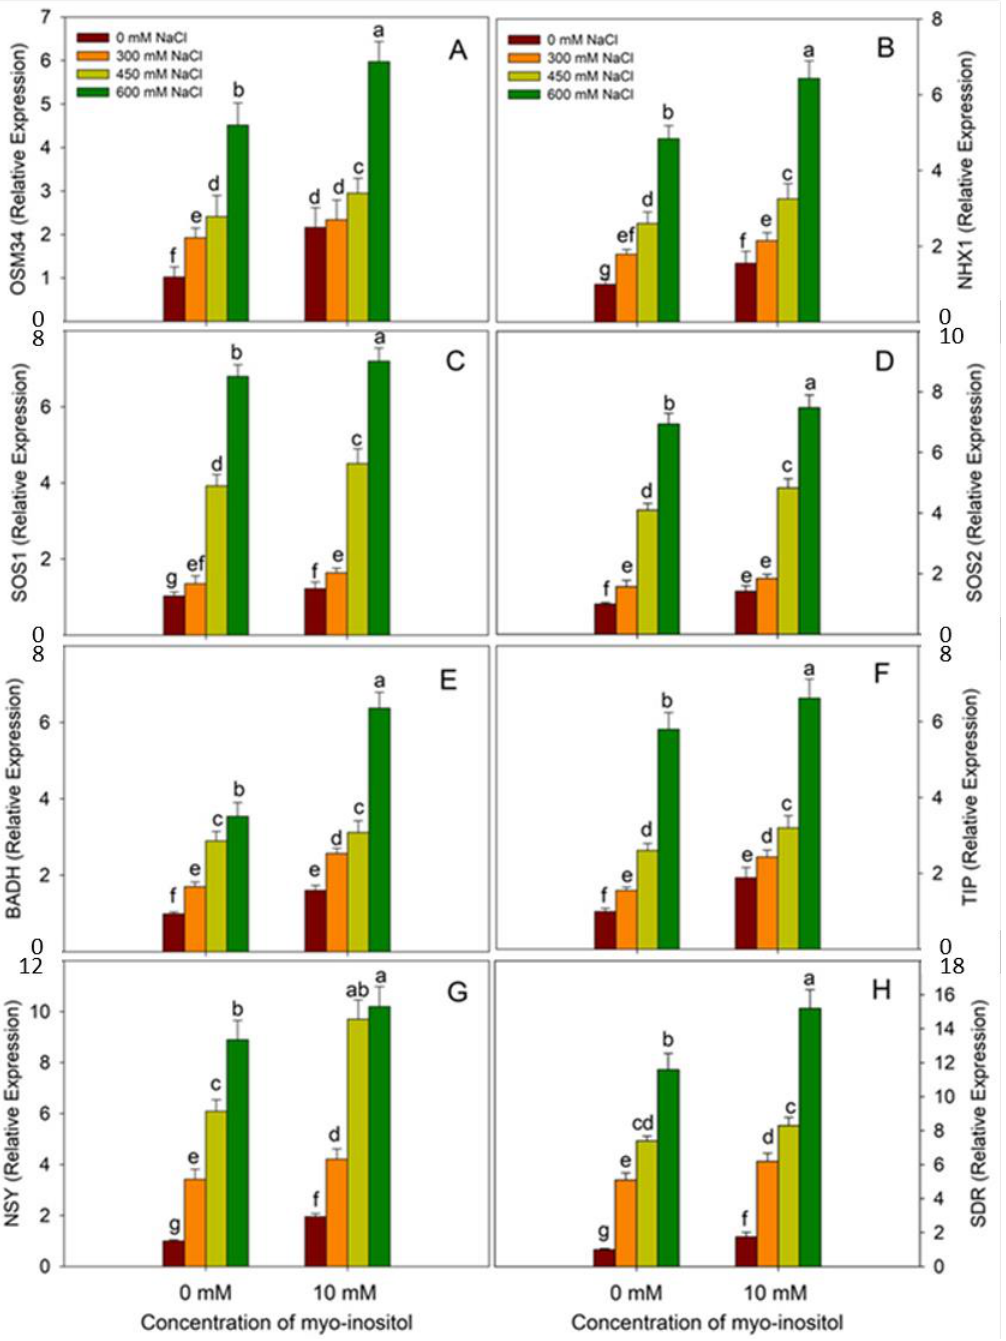
Figure 9. Effect of different salinity (300, 450, and 600 mM NaCl) concentrations with and without exogenous application of myo-inositol (10 mM) on changes in relative gene expression of salinity-stressed proteins and genes involved in ABA and glycine betaine biosynthesis in Quinoa ( Chenopodium quinoa L. var. Giza1). Data expressed as ( A ) osmotin-like protein (OSM34); ( B ) sodium/proton exchanger (Na/H + ) (NHX1); ( C ) salt overly sensitive 1A (SOS1A); ( D ) salt overly sensitive 1B (SOS1B); ( E ) betaine aldehyde dehydrogenase (cqBADH); ( F ) tonoplast intrinsic protein 2 (TIP2); ( G ) neoxanthin synthase (NSY); and ( H ) short chain-dehydrogenase/reductases (SDR). Values are mean ( ± SE) of four replicates, and different letters represent significant differences at p ≤